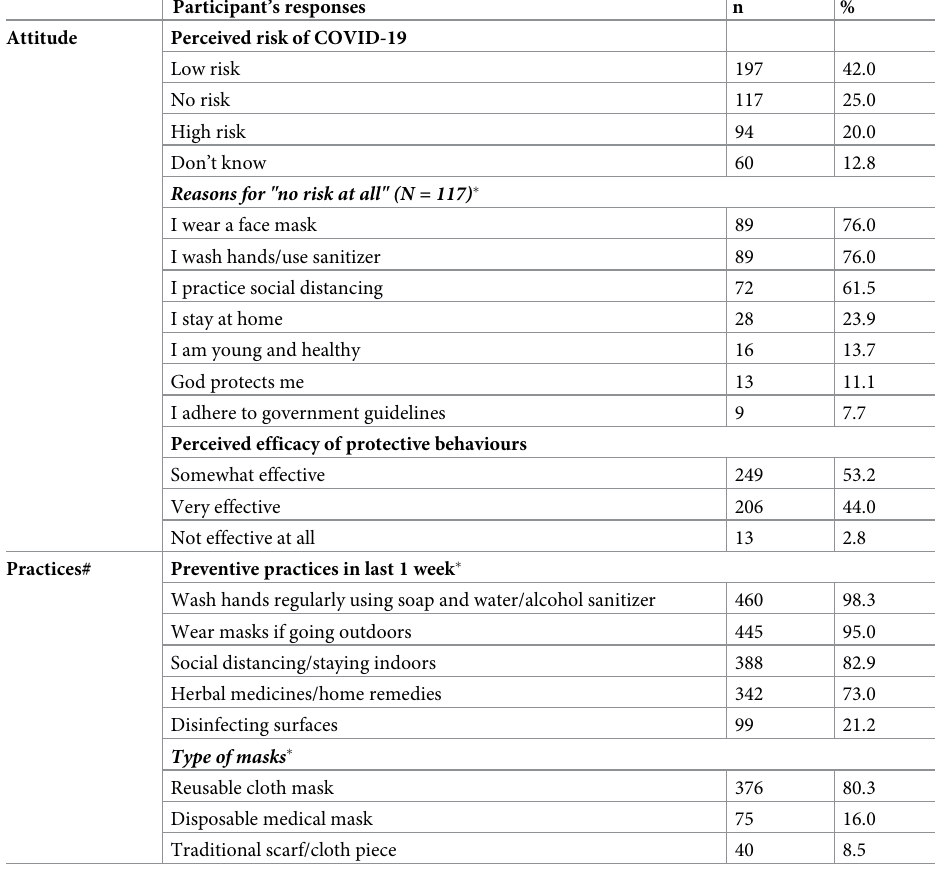
Table 5. COVID-19 related attitude and practices of survey participants among Dharavi residents, Mumbai, India (N =